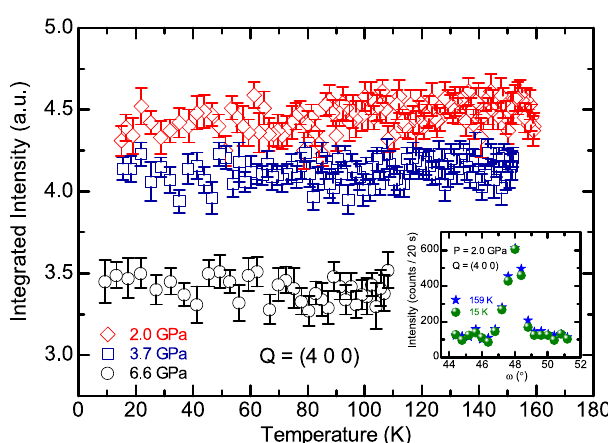
Figure 4. Temperature dependencies of the integrated intensity of the (4 0 0) and (1 0 3) reflections ( a ), and the (0 0 3) and (2 0 0) reflections ( b ), respectively, measured by neutron diffraction on the Eu(Fe 0.925 Co 0.075 ) 2 As 2 single crystal at ambient pressure. The dash line and dot line in ( a ) mark the structural phase transition and the SDW transition of Fe, respectively. The short dash line in ( b ) marks the magnetic transition associated with the canted AFM order of the Eu 2 + spins.